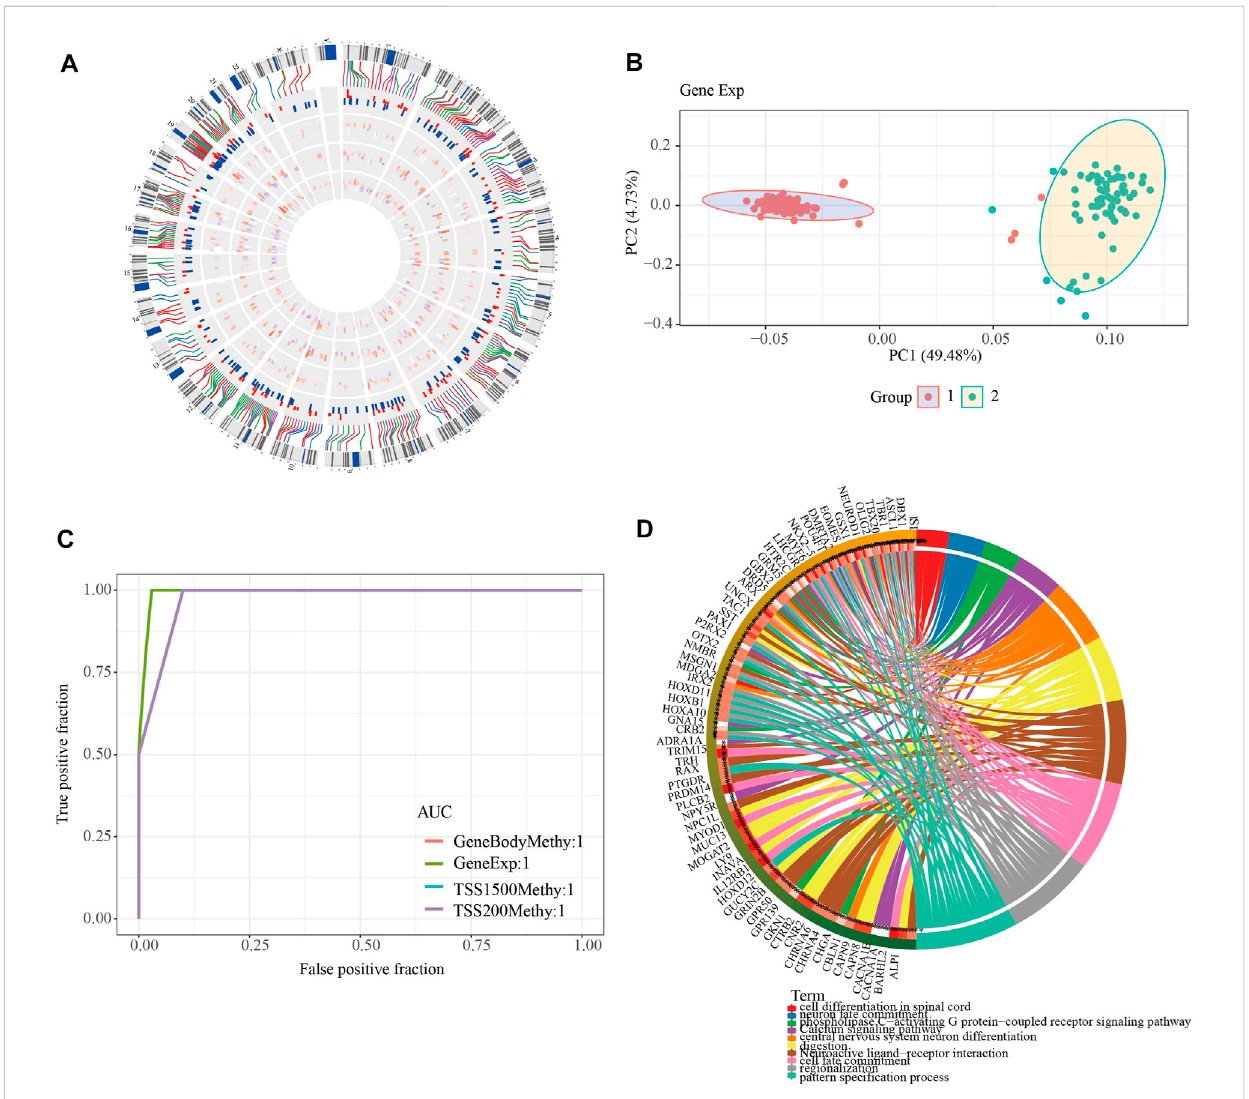
FIGURE 4 Analysis of DMEGs. (A) Distribution of DMEGs on the genome. From inside to outside, there are DMGs in the TSS1500 region, DMGs in the TSS200 region, DMGs in the genebody region, DEGs, and corresponding values. The outermost circle is the corresponding chromosome position. (B) PCA analysis could distinguish tumor from normal samples based on the gene expression and methylation of DMEGs. (C) ROC curves of tumor and normal samples based on a linear discriminant model using the expression pro fi les and methylation of DMEGs. (D) Results of KEGG and GO enrichmentanalysis ofDMEGs, where different colors represent differentpathwaysand connecting linesrepresent the existence ofassociation between genes and